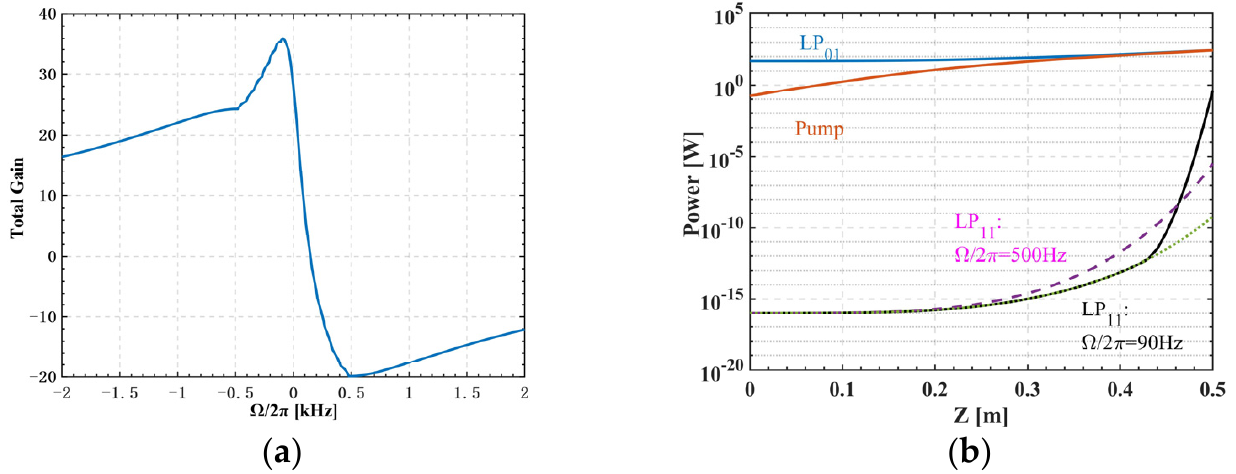
Figure 2. ( a ) The total gain and ( b ) different mode power in the 80/250 µm fiber amplifier.